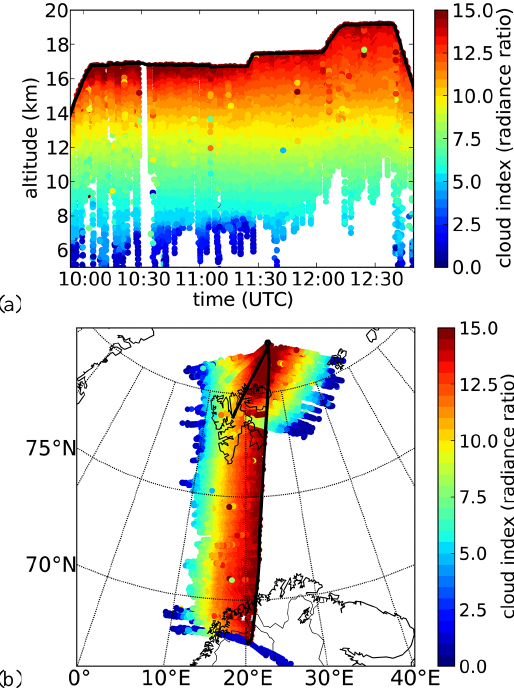
Fig. 2. Modified potential vorticity (mPV) derived from ECMWF operational analysis data for RECONCILE flight 11 (2 March 2010). Panel (a) shows mPV at the tangent points of the CRISTA- NF measurements and panel (b) shows the horizontal distribution of mPV at 81mbar at 12:00UTC. For details see caption of Fig.